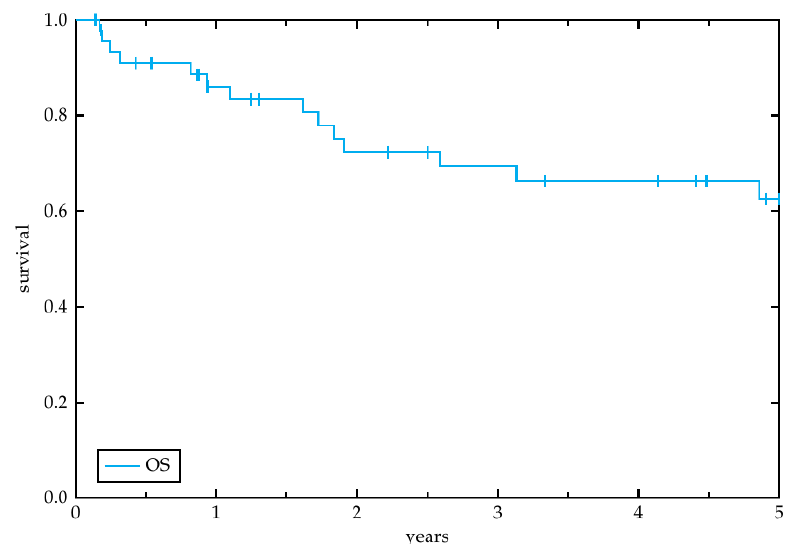
Figure 2. Overall survival. Kaplan-Meier plot representing the overall survival of the 46 patients, enrolled in this study, within the 5-year period after radiotherapy